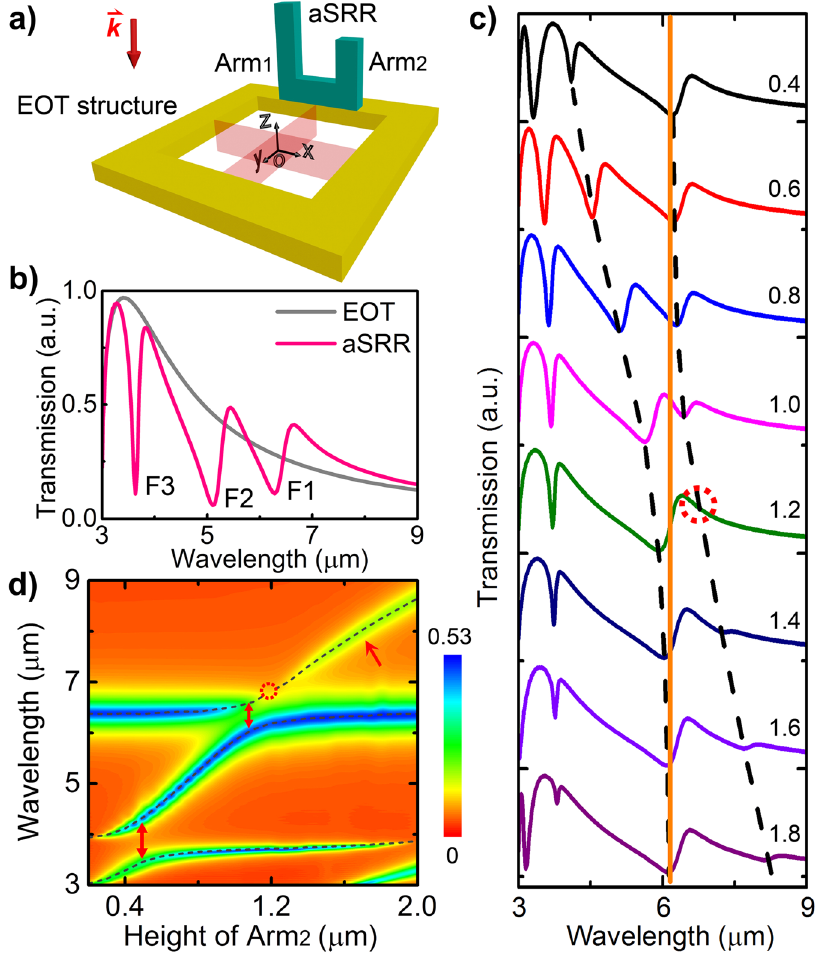
Figure 2. Triple Fano resonances and double Rabi splittings. ( a ) Schematic of the proposed substrate-free 3D structure made of gold, which consists of vertical asymmetric SRRs (with arms of Arm 1 and Arm 2 ) standing along one edge of the metallic hole array with EOT properties. ( b ) Simulated transmission spectra of an EOT structure and the proposed 3D structure with arm height of H Arm1 = 1.2 µ m and H Arm2 = 0.8 µ m. Y-polarized light excitation is used throughout this work. Triple Fano resonances noted by F1, F2, and F3 are clearly observed. ( c ) Simulated transmission spectra of the 3D structure with H Arm1 = 1.2 µ m and different H Arm2 as noted. The dashed curves and vertical straight line (guides to the eye) clearly reflect the anticrossing behavior between Fano resonance F1 and F2 (the anticrossing between Fano resonance F2 and F3 is manifested in Supplementary Fig. S3). This anticrossing in multiple Fano resonances has not been seen in any uncoupled Fano resonant systems 26, 30 . ( d ) Colormap of the simulated absorption spectra of the proposed structure versus the height of Arm 2 . The Fano resonance wavelengths as plotted by the dashed curves are identified more clearly in absorption spectra (Supplementary Fig. S1). The red double-head arrows indicate the position of F1-F2 (above) and F2-F3 (below) anticrossings, of which the Rabi splitting energy is ~17 and ~76 meV, respectively, in contrast with the resonance energy of ~190 and ~320 meV. The red single-head arrow points out the recovery of the diminished branch of the upper band during F1-F2 anticrossing. The dashed circles in Fig. 2c,d indicate the singularity in F1-F2 anticrossing when H Arm1 = H Arm2 = 1.2 μ m. Structural parameters (defined in Supplementary Fig. S1): lattice periodicity p = 3 µ m, square hole width a = 2 µ m, Au film thickness d = 80 nm, width of SRR l = 1 µ m, and SRR arm width w = 0.25 µ